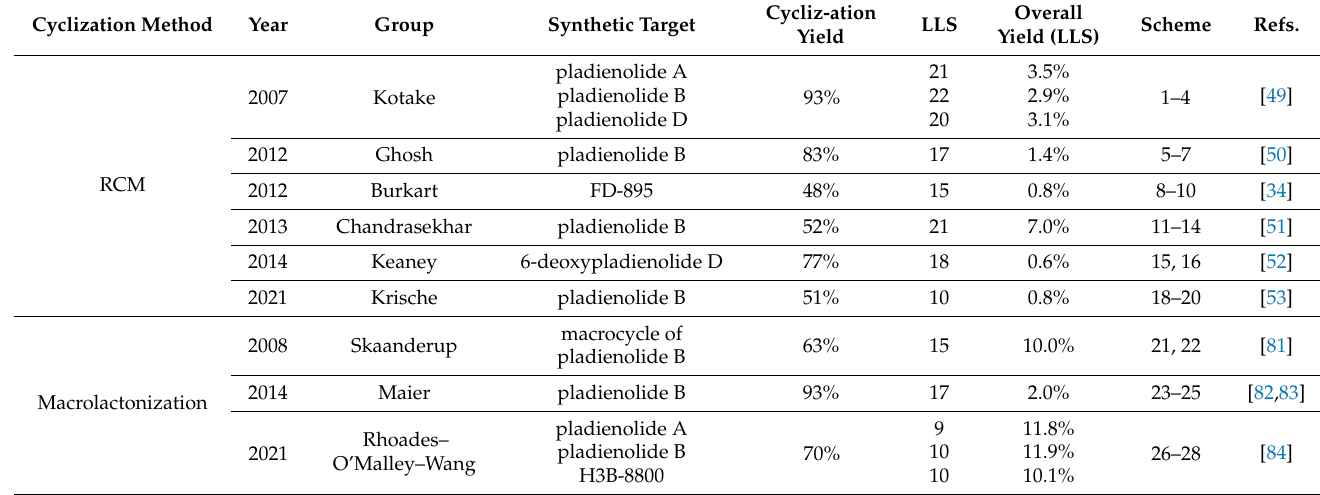
Table 1. Summary of total syntheses of pladienolides.